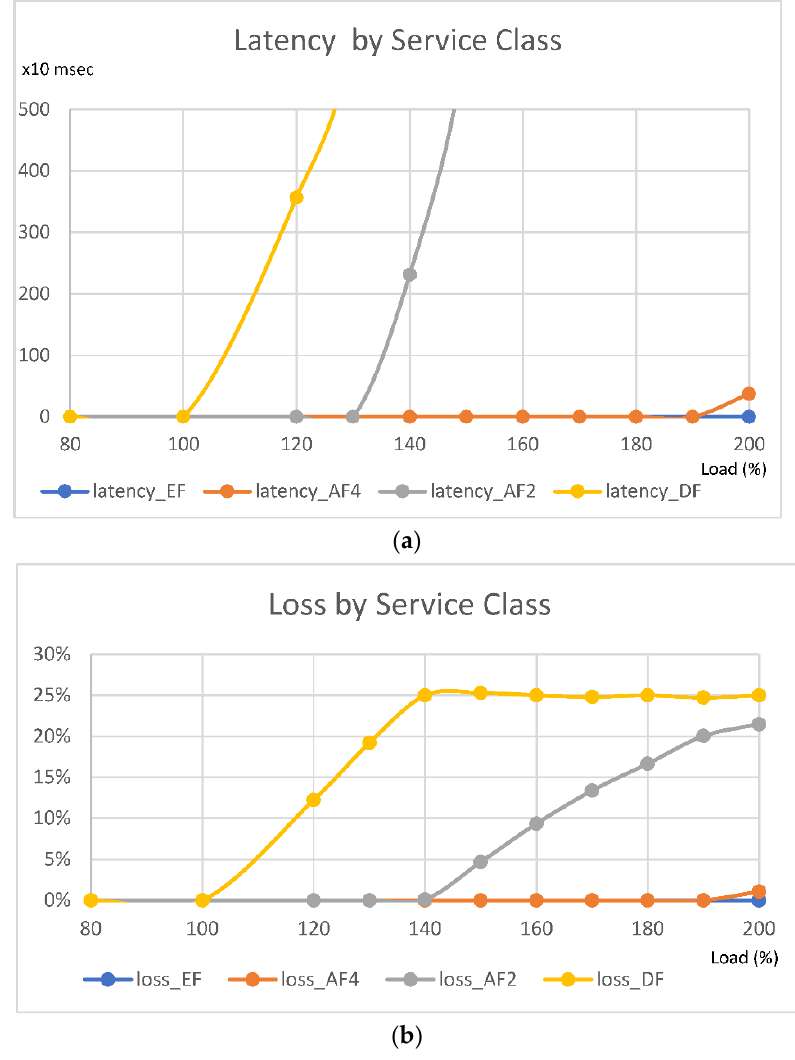
Figure 7. Performance results by service class for the EF, AF4, AF2 and DF traffic: ( a ) Latency performance by service class; ( b ) Loss performance by service class.